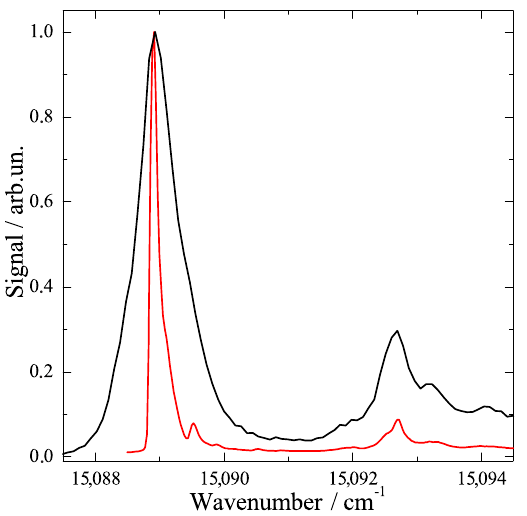
Figure 4. Electronic origin in the fluorescence excitation spectrum of phthalocyanine in helium droplets once beyond (black) and once below (red) the saturation limit. The leading intense peak represents the zero phonon line (ZPL) which is accompanied to the blue by the phonon wing